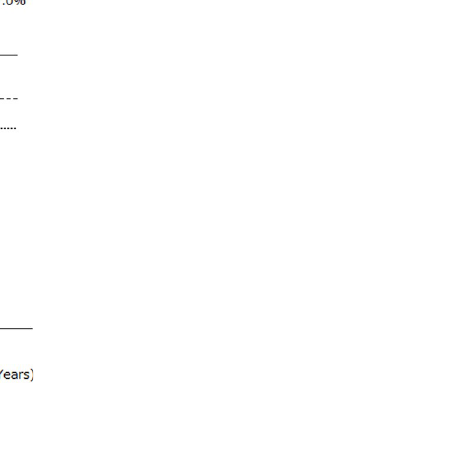
Fig 3. Kaplan–Meier survival probability curve for postsurgical patients with HbA1c < 7.0%, 7.0 � HbA1c < 8.0%, and HbA1c � 8.0% (adjusted for age and gender).